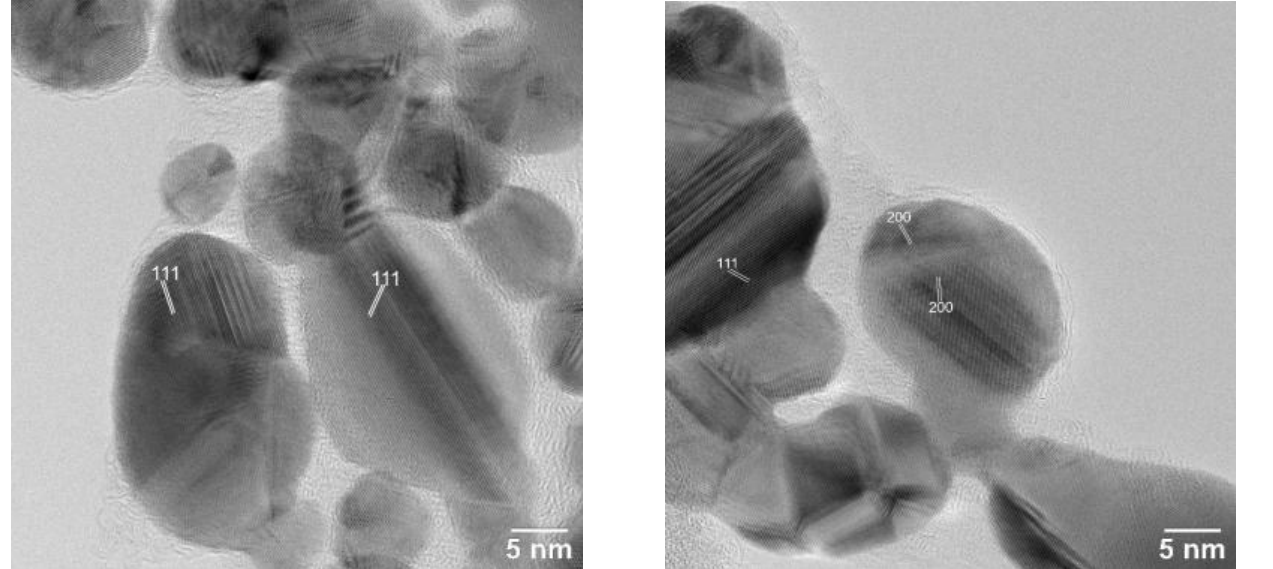
Figure 8. HRTEM images of AgNPs; the lattice fringes correspond to (111) and (200) Figure 7. HRTEM images of AgNPs; the lattice fringes correspond to (111) and (200) crystallographic crystallographic planes of FCC (face-centered cubic) AgNPs . planes of FCC (face-centered cubic)